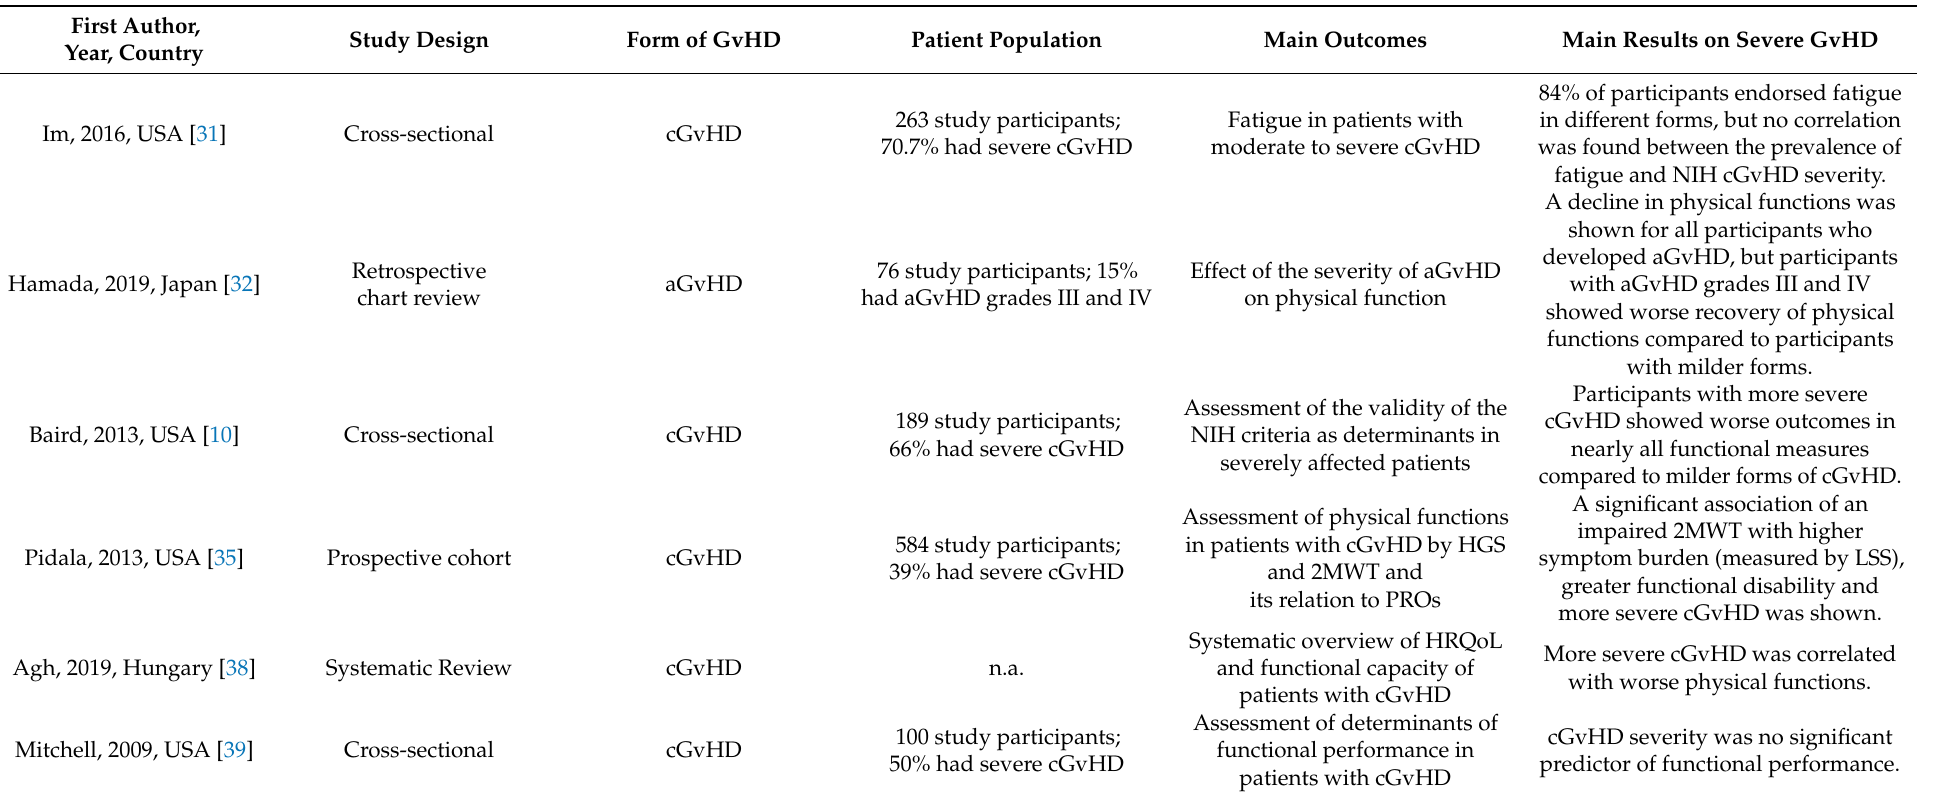
Table 1. Publications identified by the PubMed search on physical symptoms and functions in patients with GvHD, with specific results on severe